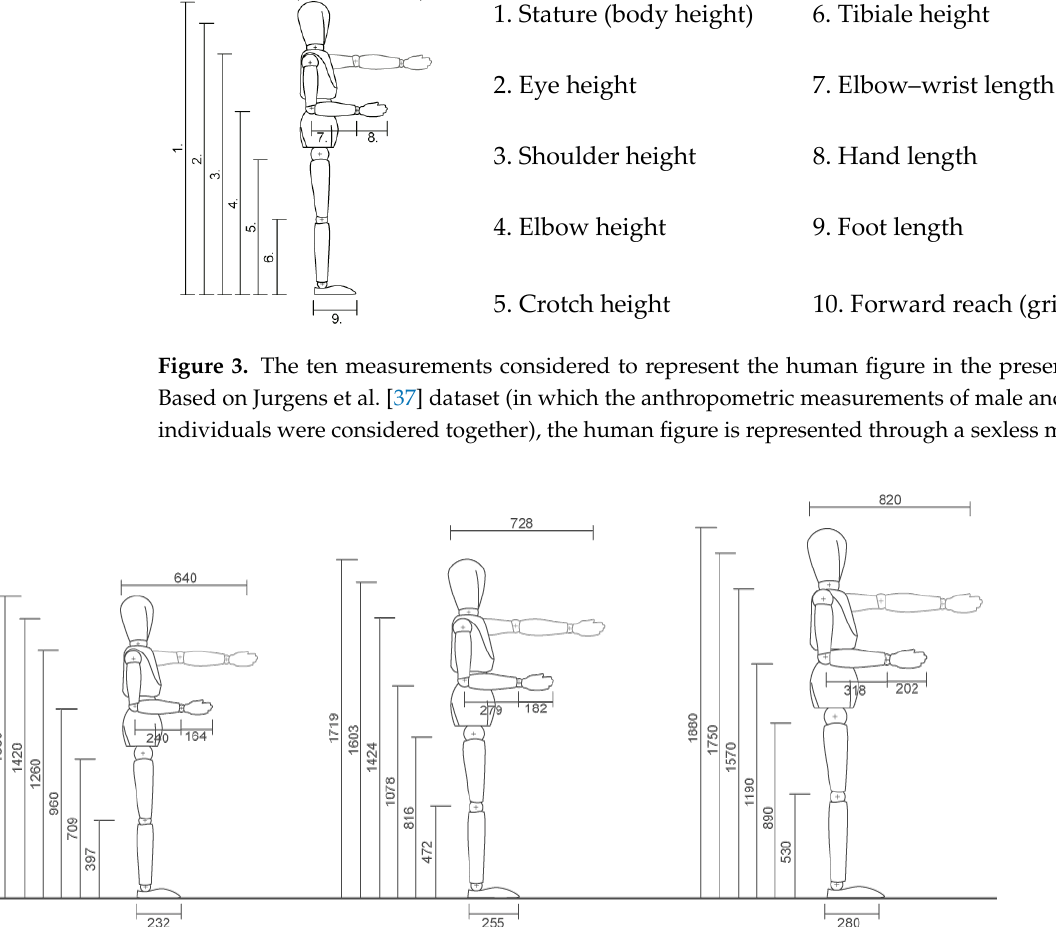
Figure 5. Representation of the tractor, based on the average measurements collected on field. 2.3. Development of the Accessible Zones Through the Merge of the Human and Tractor Repre- sentations After having graphically and metrically defined both the human figure and the trac- tor features, the manikins of the 5th, 50th, and 95th percentiles were overlapped to the tractor representation to easily identify the interaction points between the human figure and the machine. The postures of the manikins and their distances from the tractor were designed based on those detected in previous field observations [16,17]. Only as a graph- ical reference, the manikins reported in the results section have been depicted with the right arm raised, simulating the grasp of the roll-bar when it was at 45°, and the left arm extended, simulating the grasp of the roll-bar when it was at 90°. To develop the accessible zones adapted to the three percentiles considered, the ex- isting accessible zones used in the OECD Codes were scaled by adopting specific